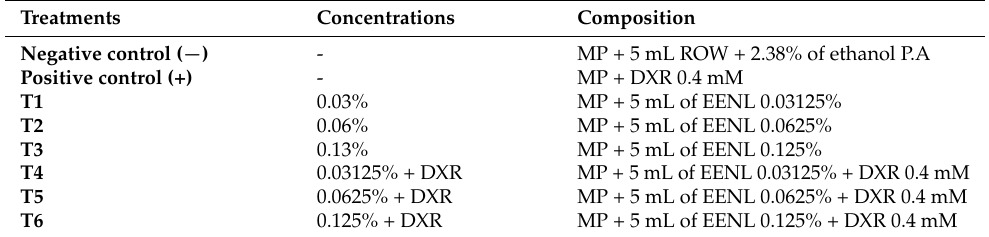
Table 3. Drosophila melanogaster larvae treated with different concentrations of EENL. EENL were used isolated and associated with